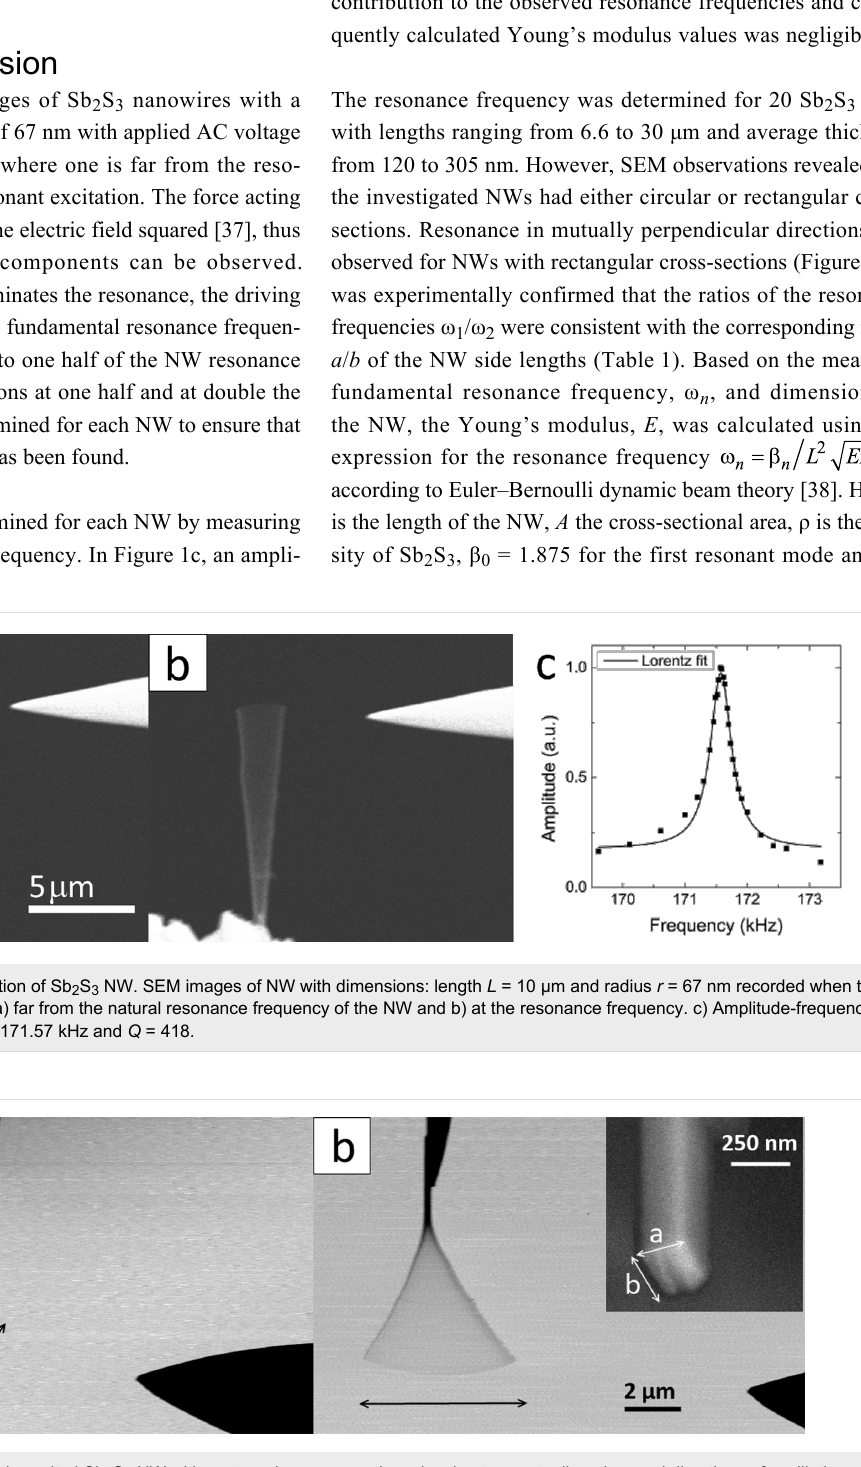
Figure 2: SEM images of resonantly excited Sb 2 S 3 NW with rectangular cross-section, showing two mutually orthogonal directions of oscillation: a) nearly perpendicular with the direction of the driving electric field and b) parallel to the direction of the electric field. Large NW deflections are used for illustrative purposes. Inset shows rectangular cross-section of